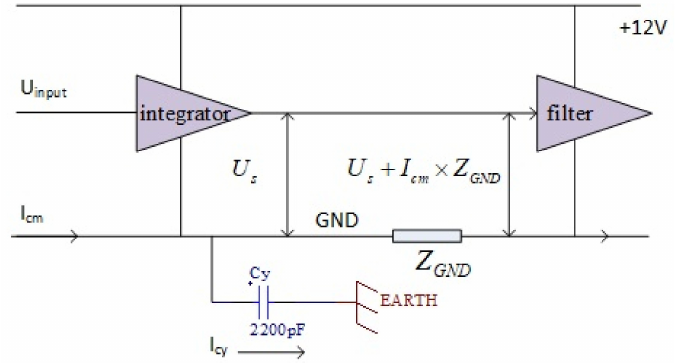
Figure 15. Voltage drops caused by common mode interference current flowing through ground